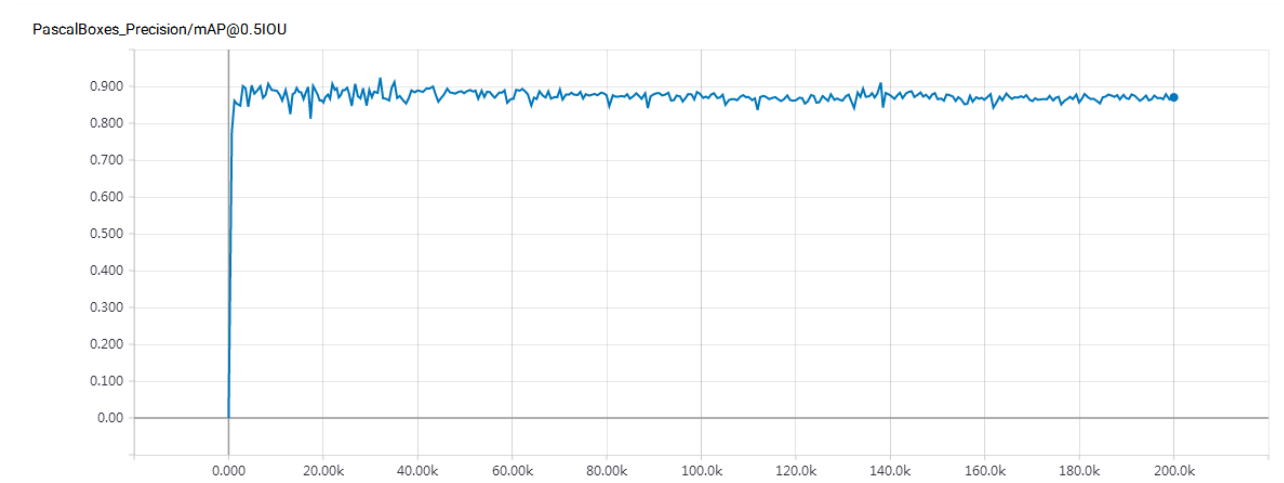
Figure 16. MAP value of faster R-CNN (50-layer ResNet) model.